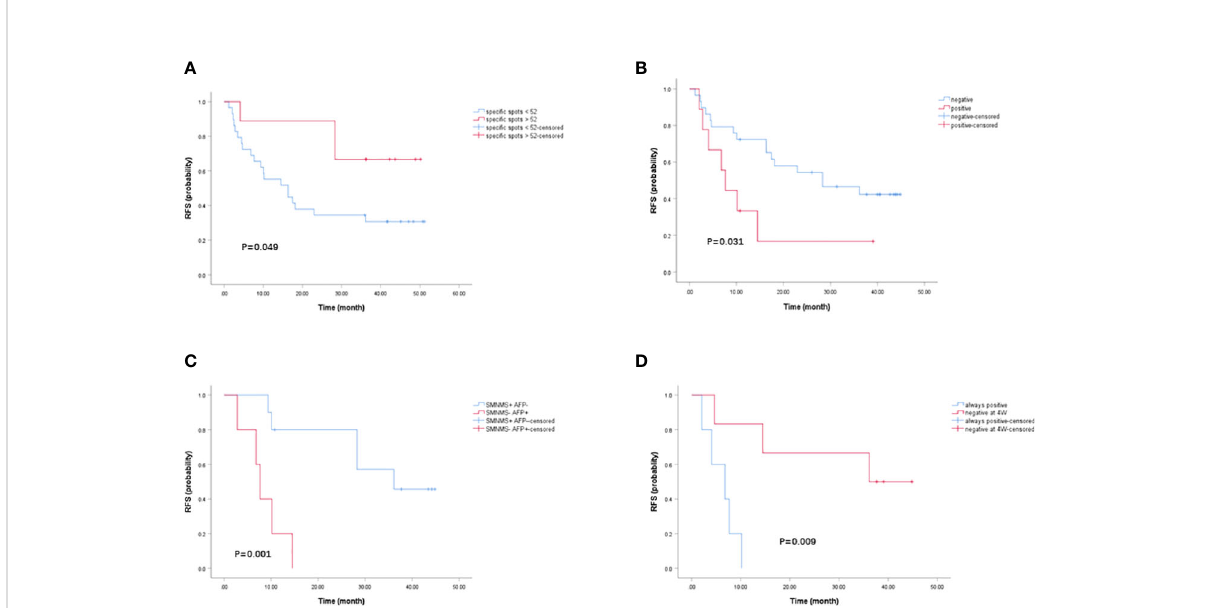
FIGURE 3 Kaplan-Meier curves of HCC recurrence-free survival. (A) Kaplan-Meier curves indicating the relationship between month after ablation and HCC recurrence-free survival rate were grouped by the median number of SMNMS-speci fi c T cells detected by IFN- g ELISPOT assay in patients with positive SMNMS-speci fi c T cell response at 1W. (B) Kaplan-Meier curves indicating the relationship between month after ablation and HCC recurrence-free survival rate were grouped by the presence of AFP-speci fi c T cell response detected by IFN- g ELISPOT assay at 1W. (C) Kaplan- Meier curves indicating the relationship between month after ablation and HCC recurrence-free survival rate were depicted between patients with “ SMNMS+ AFP- ” speci fi c T cell response and patients with “ SMNMS- AFP+ ” speci fi c T cell detected by IFN- g ELISPOT assay at 1W. (D) Kaplan-Meier curves indicating the relationship between month after ablation and HCC recurrence-free survival rate were grouped by the presence of AFP-speci fi c T cell response detected by IFN- g ELISPOT assay from 1W to